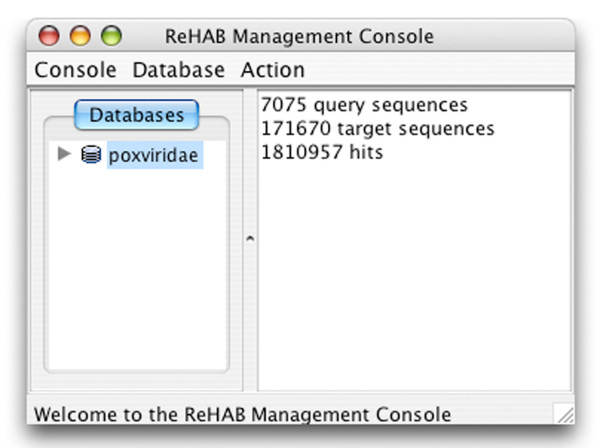
ReHAB management console. A database is selected from the list on the left, and statistics are displayed on the right. More hits than target sequences are displayed because query sequences can match multiple targets. Double-clicking on the database or selecting an option from the Action menu allows users to browse the selected database.